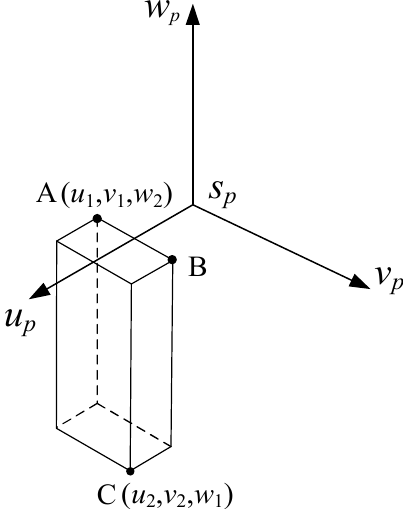
Figure 4. A single pole in the ( s p - u p , v p , w p ) coordinate system. Table 1. Equivalent surface current of MG1 on the magnet’s surface.